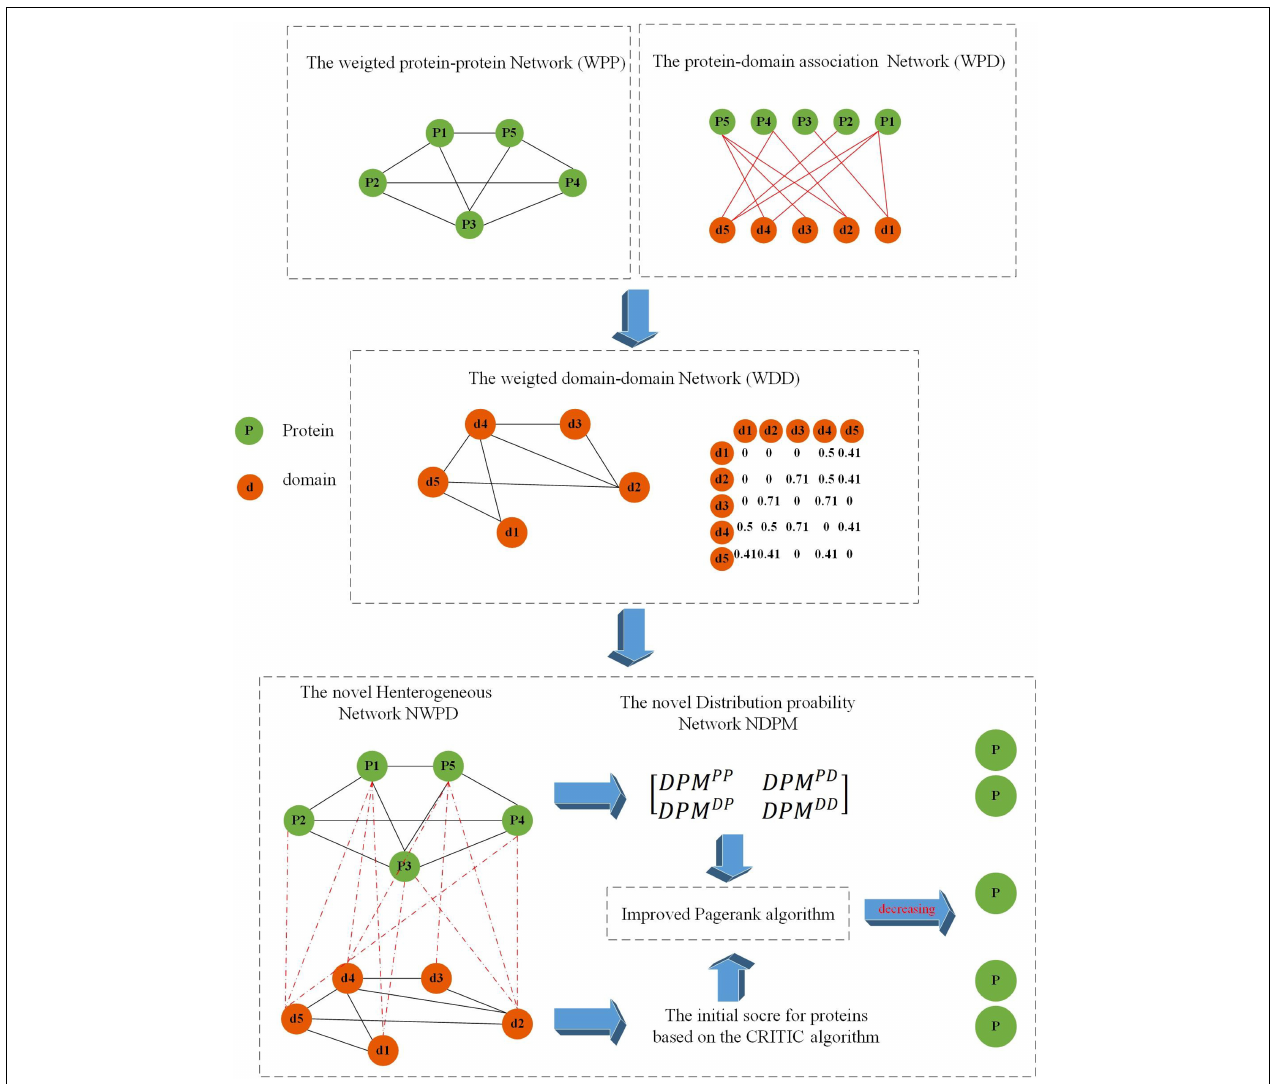
FIGURE 1 | Flowchart of